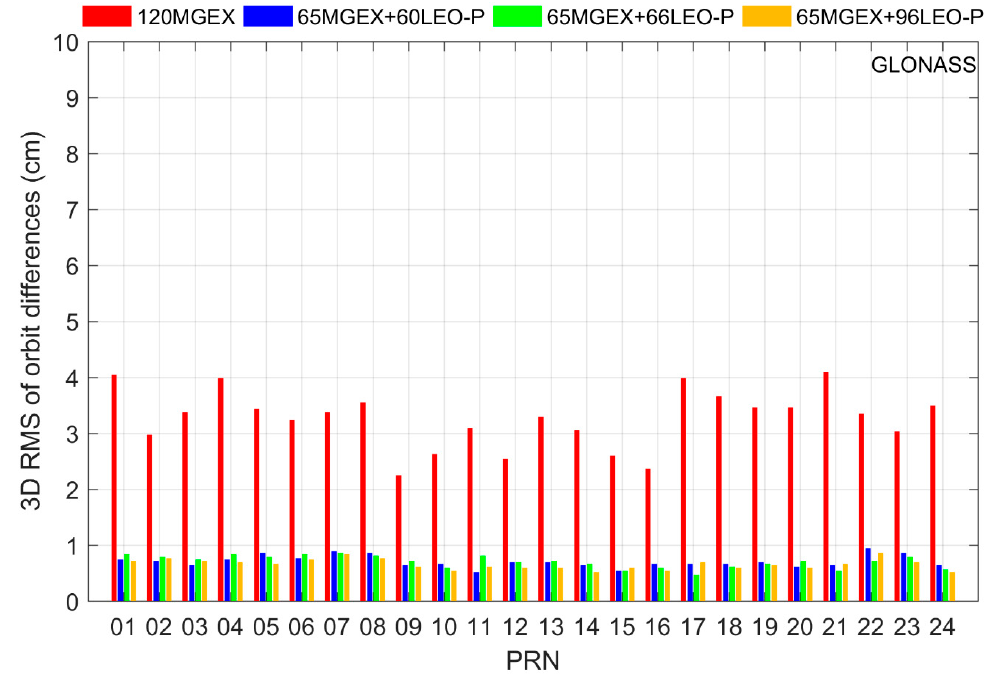
Figure 4. Average 3D RMS values of GLONASS orbit differences for the integrated POD with different numbers of LEO satellites.